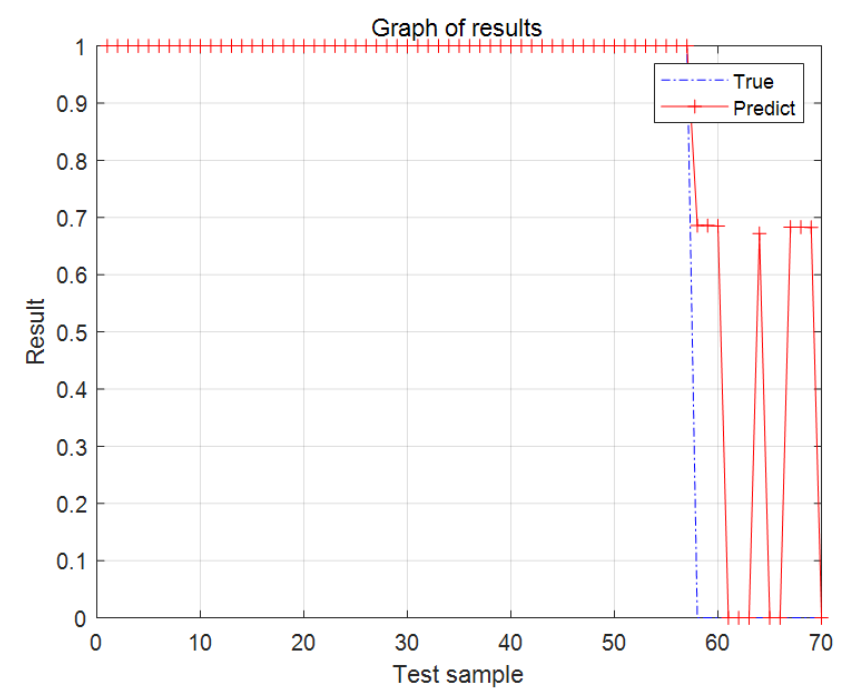
Figure 9. Plot of ELM model fits after process.